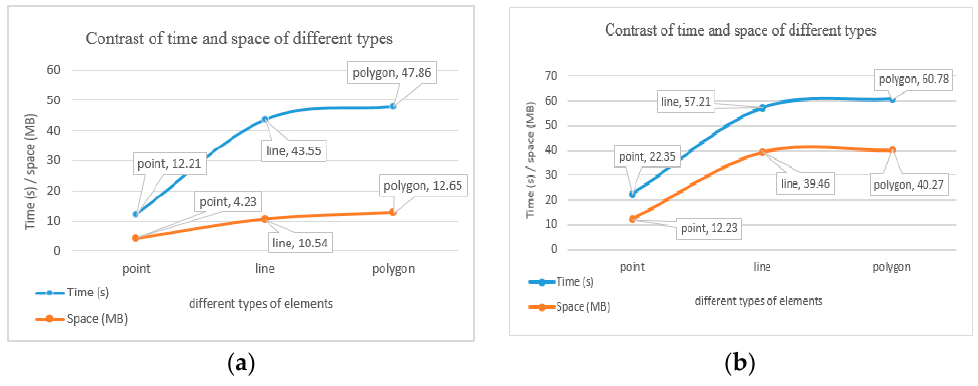
Figure 10. ( a ) Time vs. space for GML elements of different type (Example 1); ( b ) time vs. space for GML elements of different type (Example 2).